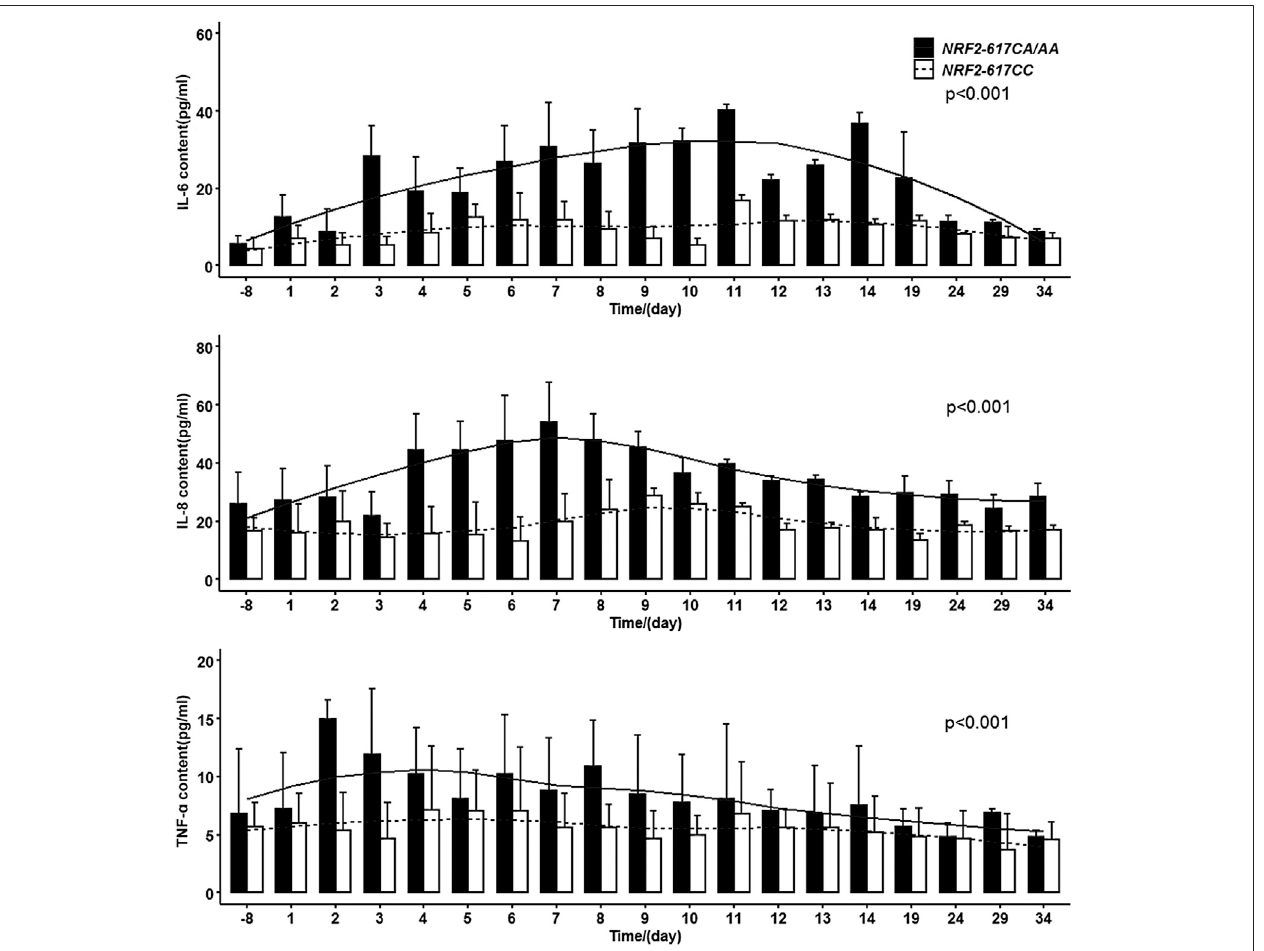
FIGURE 1 | Higher plasma IL-6, IL-8, and TNF- α levels after HSCT in adult patients with NRF2 -617 CA/AA genotypes ( n (cid:1) 37) compared to those with wild genotype ( n (cid:1) 50). Histograms of IL-6, IL-8, and TNF- α levels in the patients with NRF2 -617 CA/AA genotypes and NRF2 -617 CC genotype. Solid and dotted curves represent the locally weighted scatter plot smoothing